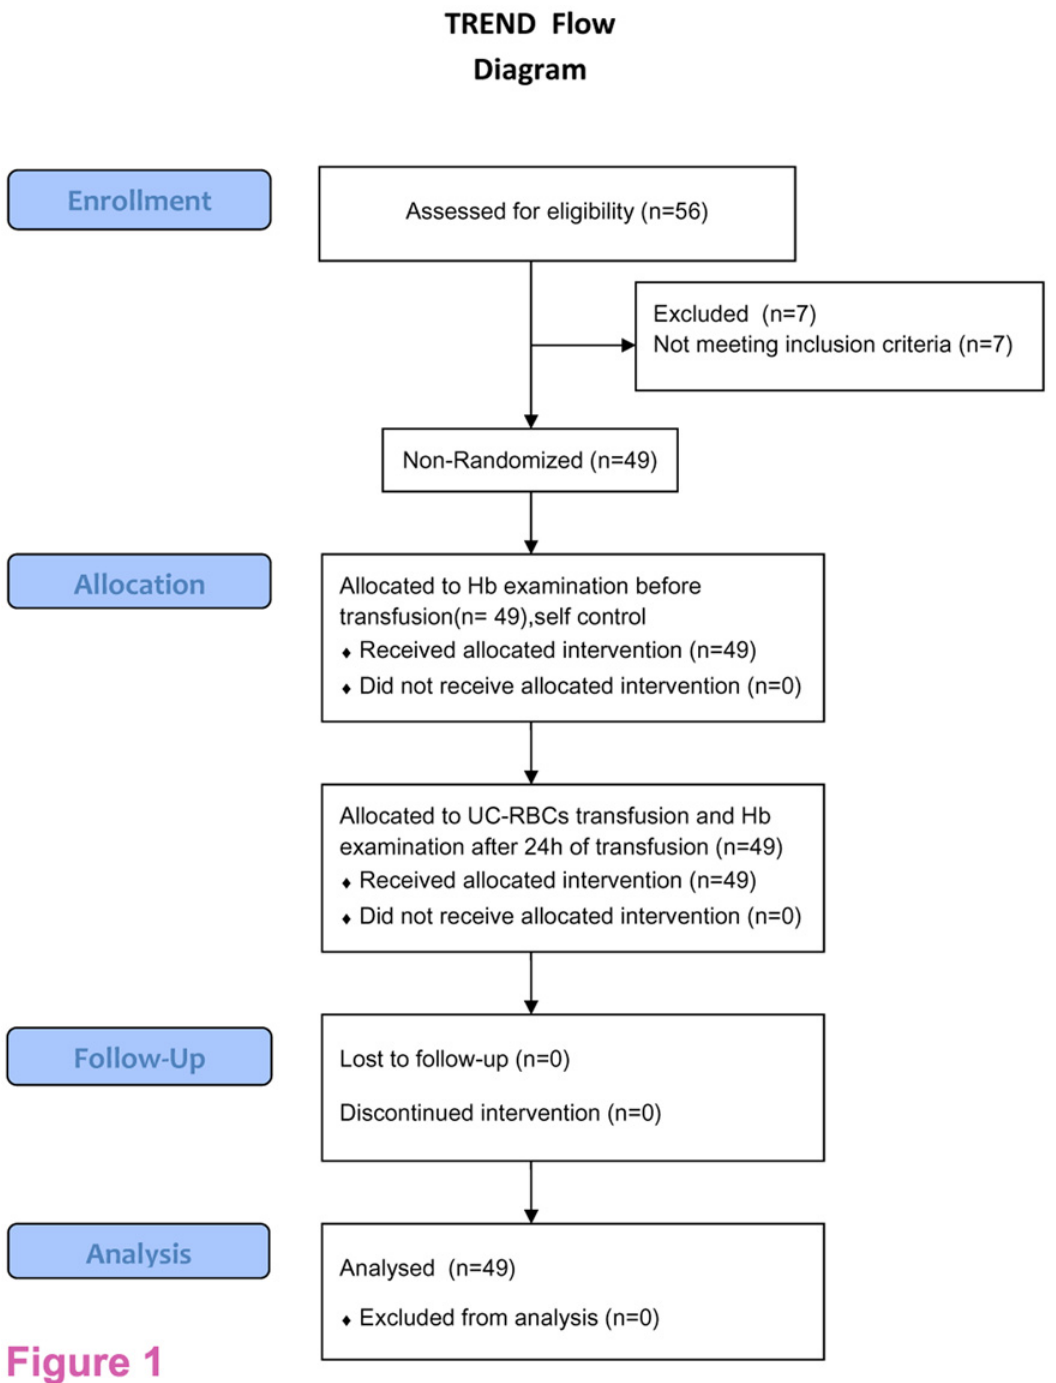
Fig 1. Flow chart of patient involvement in this clinical trial. This trial enrolled 56 participants, in which seven patients were excluded as they did not meet inclusion criteria.